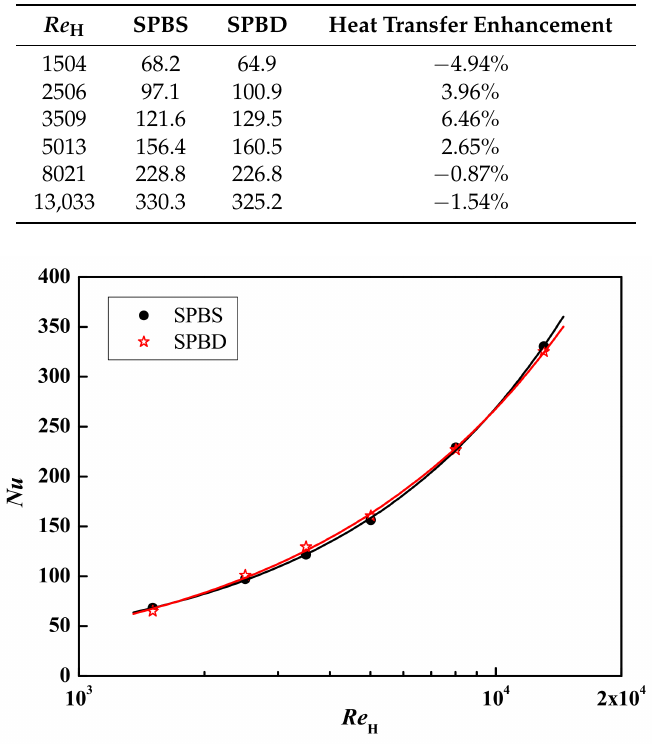
Figure 10. The Nusselt number of the structured packed bed with smooth or dimpled spheres at N =